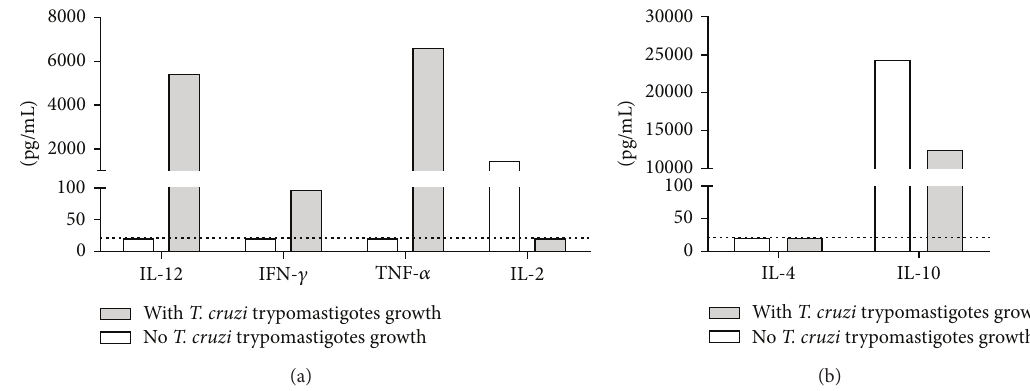
Figure 1: T. cruzi trypomastigotes outgrowth from endomyocardial biopsies from CCC patients induces the production of T1-type cytokine profile.